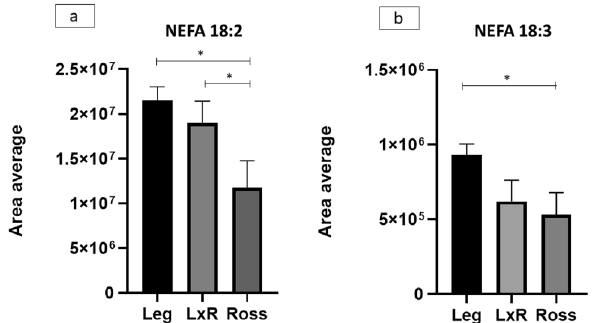
Figure 1. n-6 and n-3 non-esterified fatty acids (NEFA) of chicken liver: ( a ) 18:2 (linoleic acid, LA; precursor of n-6 LC PUFA); ( b ) 18:3 (α-linolenic acid, ALA; precursor of n-3 LC PUFA). Leg: Leghorn genotype; LxR: crossbreed, Ross: Ross 208 genotype. *P < 0.05 (post hoc Tukey’s test).